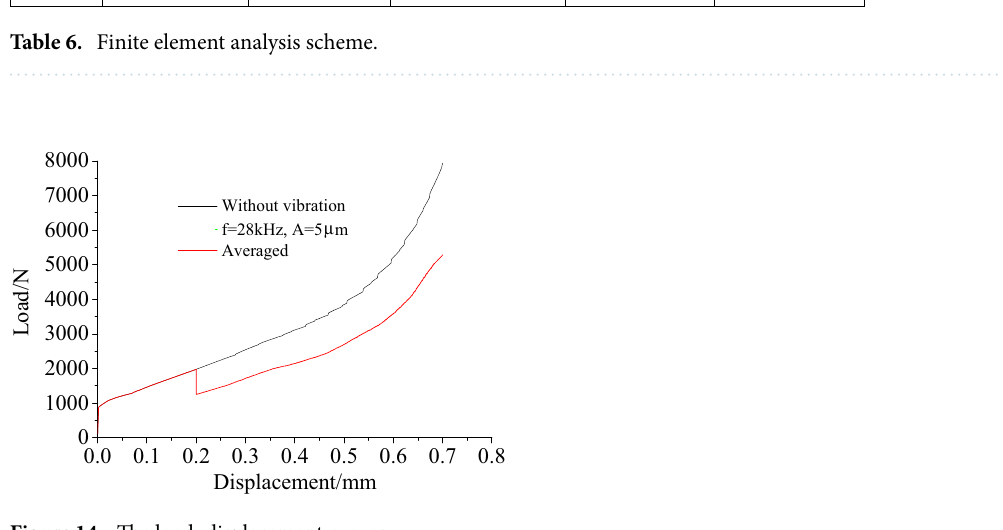
Figure 14. The load–displacement